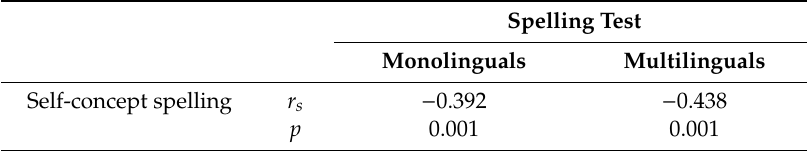
Table 5. Correlations between self-concept for spelling and the standardized spelling test